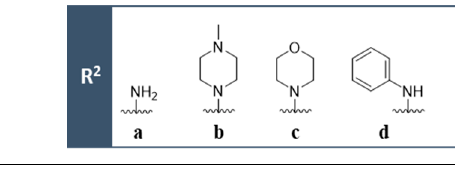
Table 1. Description of the physicochemical and structural properties of the ligands under study and